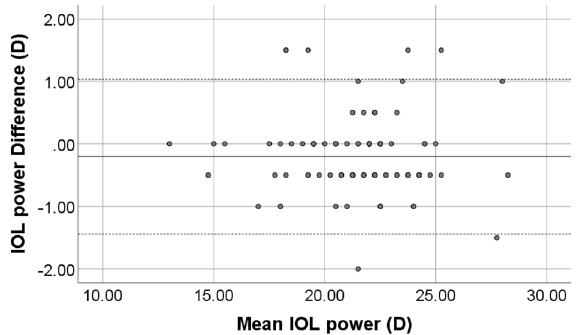
Figure 4. Bland–Altman plot of the IOL power using parameters from GALILEI G6 and ANTERION. The solid line represents the mean difference, whereas the dots on each side show the upper and lower 95% LoA. The plot demonstrates that six eyes at IOL power difference of ± 1.5 D (5 eyes) and 2 D (1 eye) from the total of 96 eyes were out of the 95% LoAs, indicating excellent agreement between the two devices’ measurement of IOL power. Created by SPSS (Version 22, SPSS Inc., IBM, Chicago,